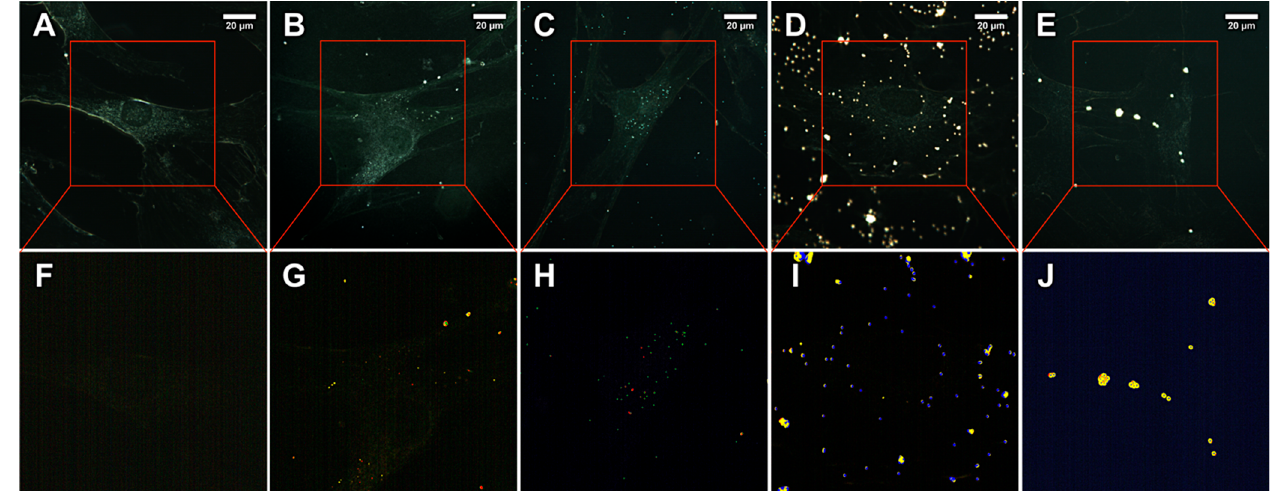
Figure 3. Dark-field images (upper row) and corresponding hyperspectral images merged with maps (bottom row) demonstrating the distribution of polystyrene particles in HSF after 24 h of co-incubation: control ( A , F ); 100 nm ( B , G ); 200 nm ( C , H ); 500 nm ( D , I ); and 1000 nm ( E , J ). Red-, green-, blue- and yellow-coloured pixels on hyperspectral images denotes 100, 200, 500, and 1000 nm particles mapped by Spectral Angle Mapper, respectively.